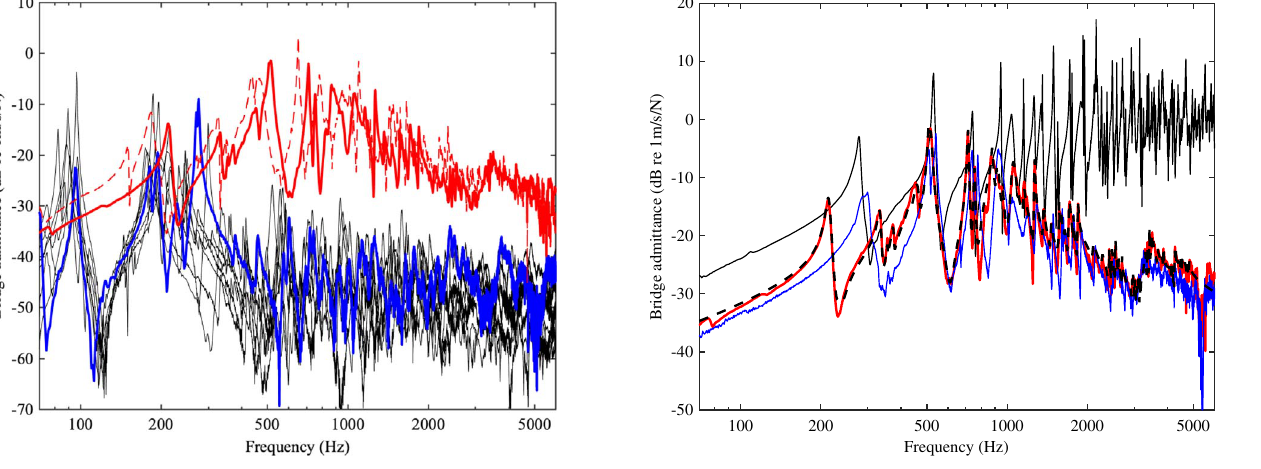
Figure 5. Measured drive-point admittance functions, all close to the bridge notch for the fi rst string. Heavy red line: Deering banjo; dashed red line: Ozark banjo; heavy blue line: Woodhouse steel-string guitar; black lines: six other guitars of various types (see text).